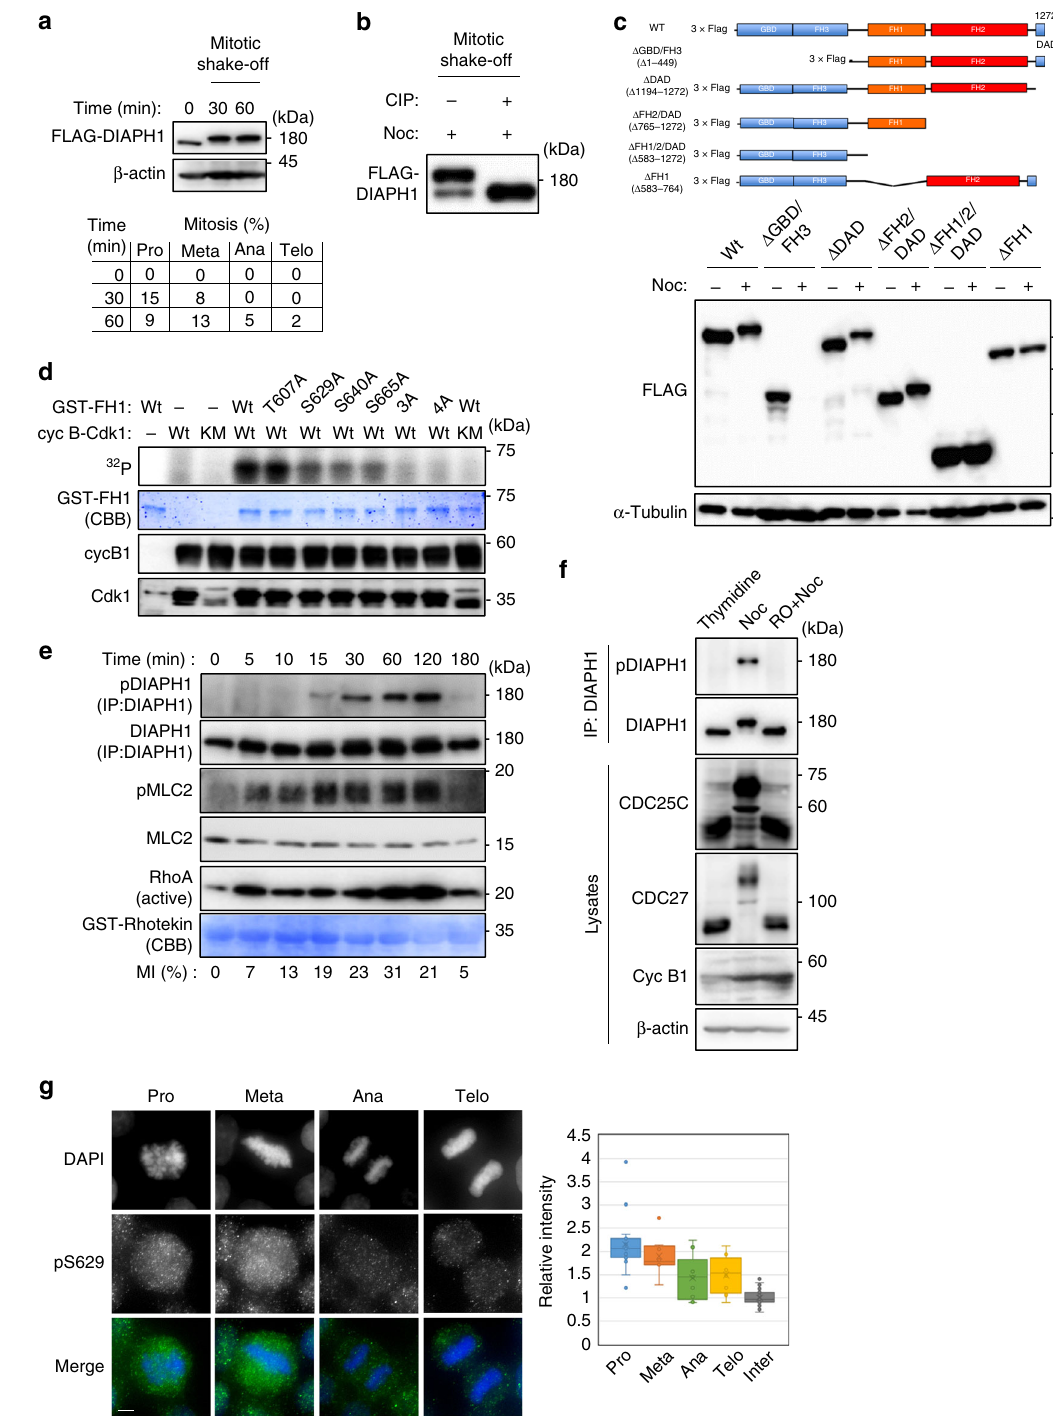
The FH1 phosphorylation suppresses DIAPH1 – PFN1 interac- tion . Pro fi lins mediate monomeric actin recruitment to formins 24,25 . GST-pro fi lin1 (PFN1) bound preferentially to unphosphorylated DIAPH1 and only barely to the phosphory- lated form while PFN1 consistently bound to actin in HeLa cells (Fig. 2a), suggesting that mitotic DIAPH1 phosphorylation likely downregulates its actin nucleation and elongation activity through the dissociation of PFN1. As expected, GST-PFN1 effectively bound to the Wt as well as to the FH1 domain of